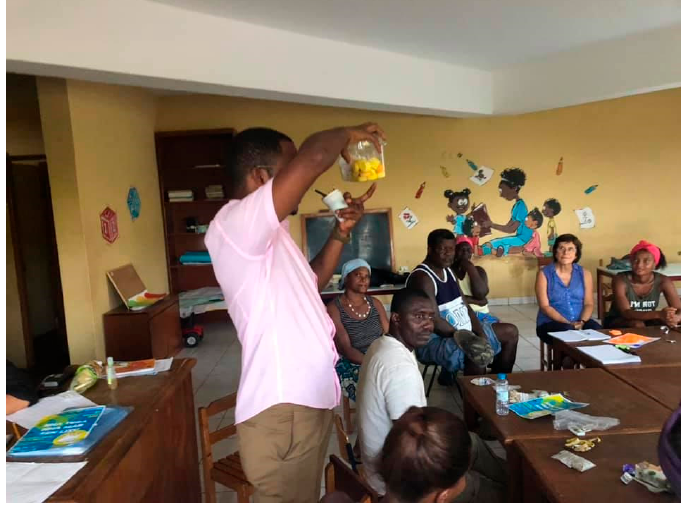
Figure A4. Active listening and brainstorming in the participatory session in Porto Mosquito. (photos by the authors, September 2019).